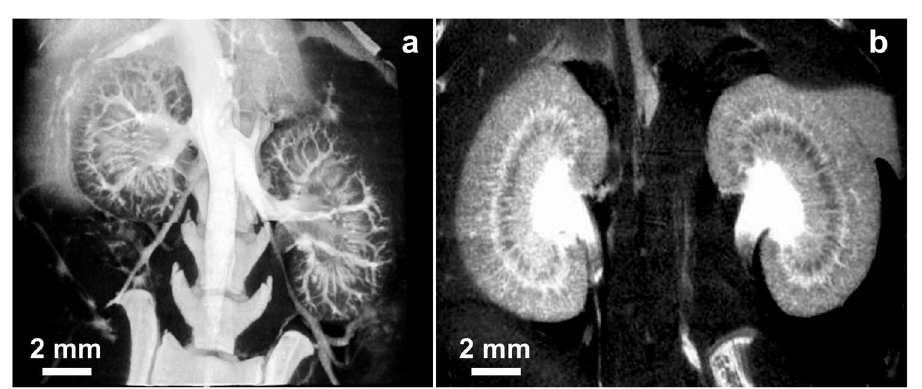
Figure 3. MicroCT coronal images of mouse kidneys 2 min after IV injection of INPs ( a ) and iohexol ( b ) (both 1.75 g